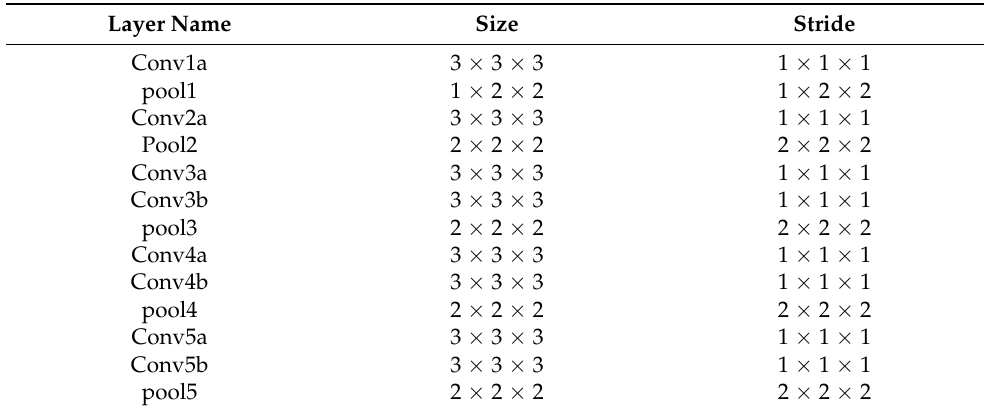
Figure 2. C3D network architecture. Table 2. The size of each layer in C3D